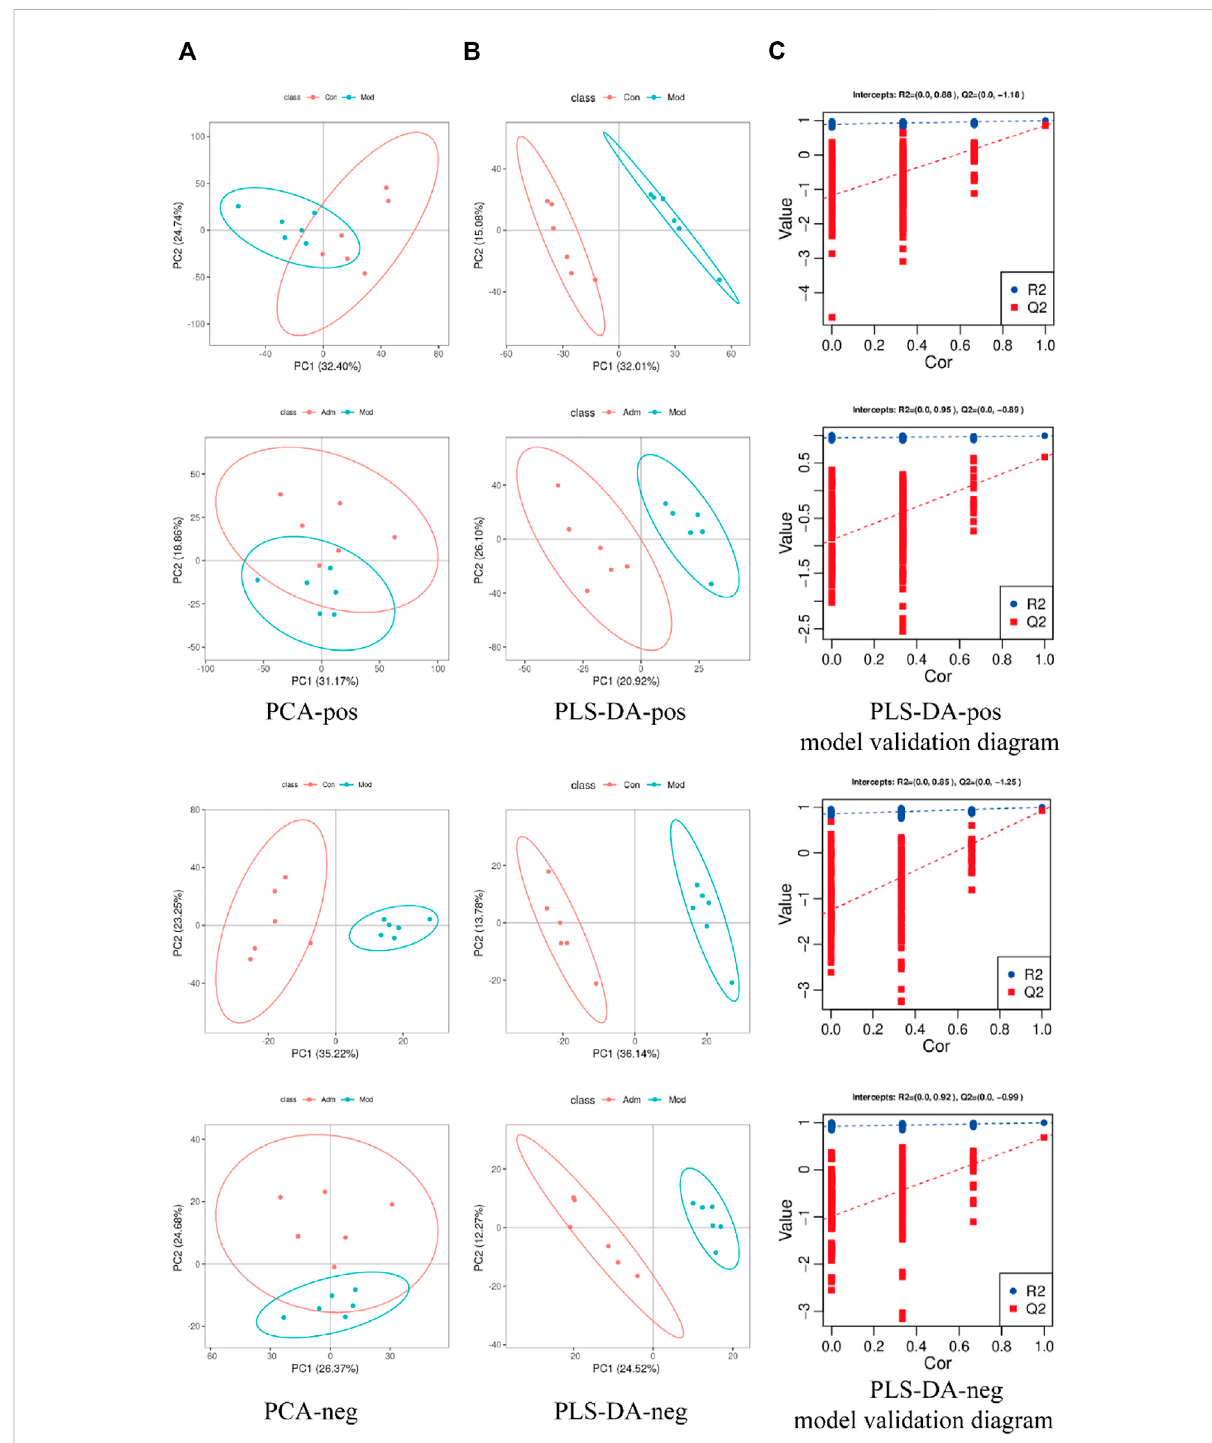
FIGURE 5 Score chart of PCA, PLS-DA model and PLS-DA model response permutation testing (RPT). (A) Score chart of PCA analysis model pos and neg (B) . Score chart of PLS-DA analysis model pos and neg. (C) PLS-DA model validation